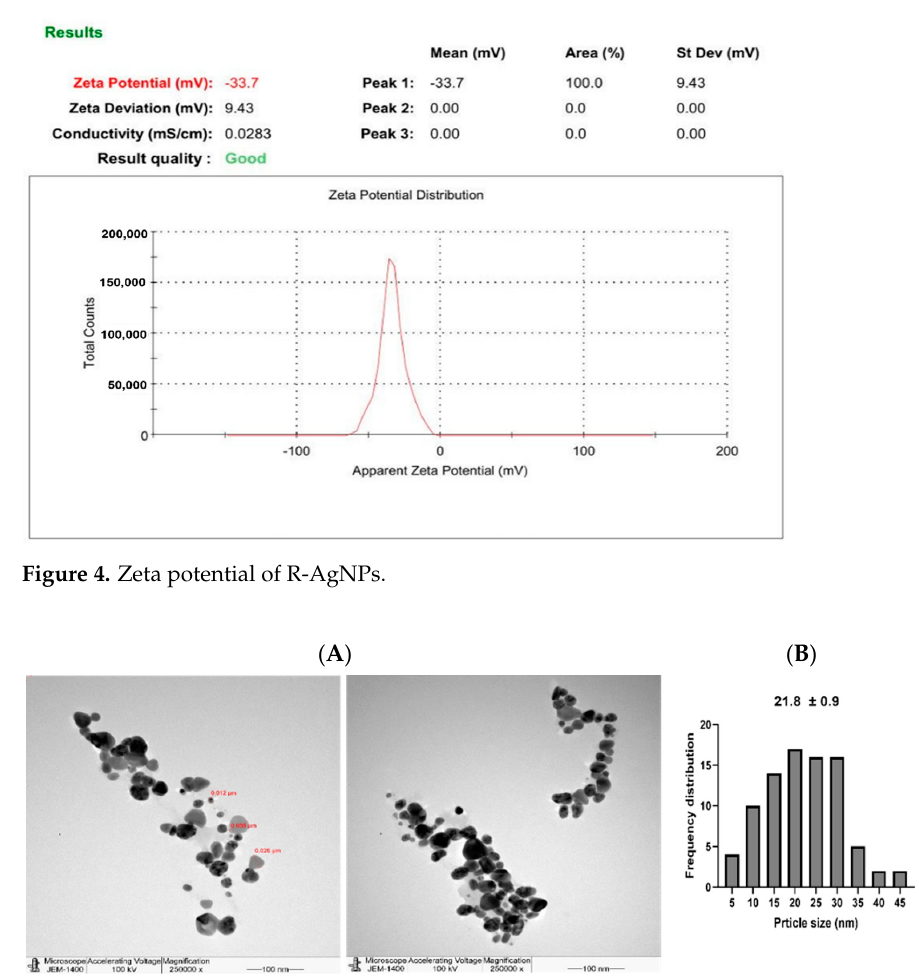
Figure 6. Spherical shape R-AgNPs ( A ) and their frequency distribution with mean particle size ( B ). Size measurements were analyzed by ImageJ software constructed from TEM micrographs at scale bars: 100 nm.